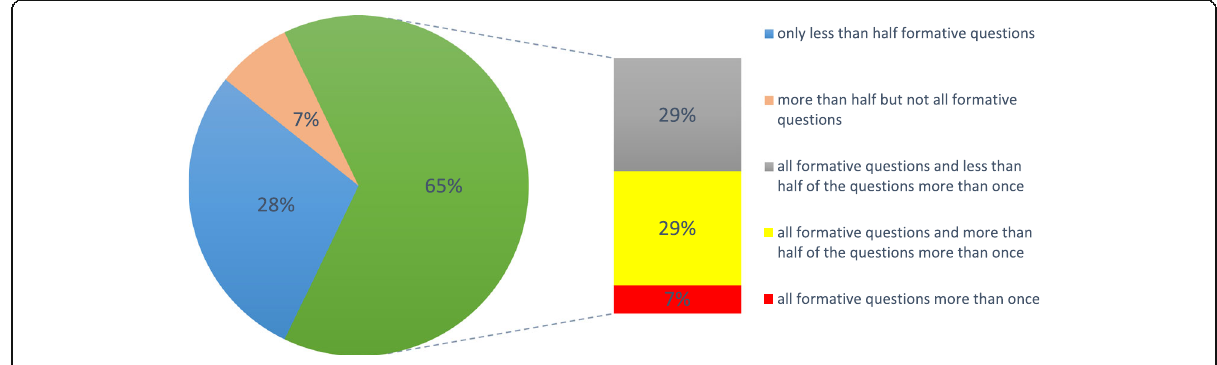
Fig. 8 Analysis of student engagement in formative questions